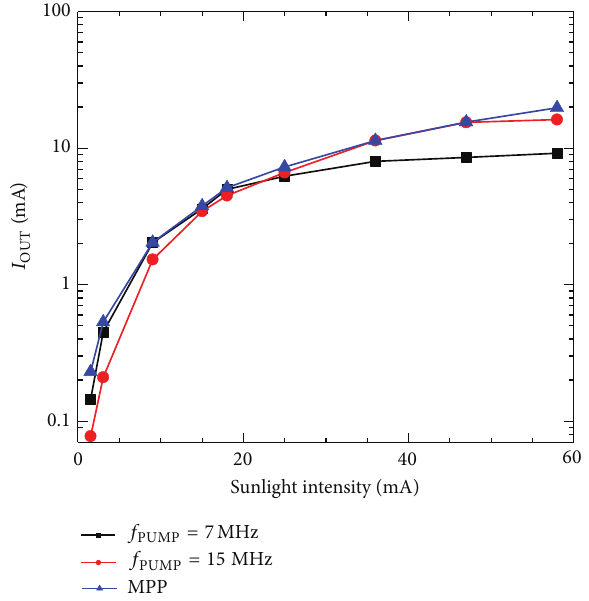
Figure 4: Comparison of output currents of RCP circuit with the fixed pumping frequencies ( 𝑓 and MPPs that are shown in Figures 3(a), 3(b), and